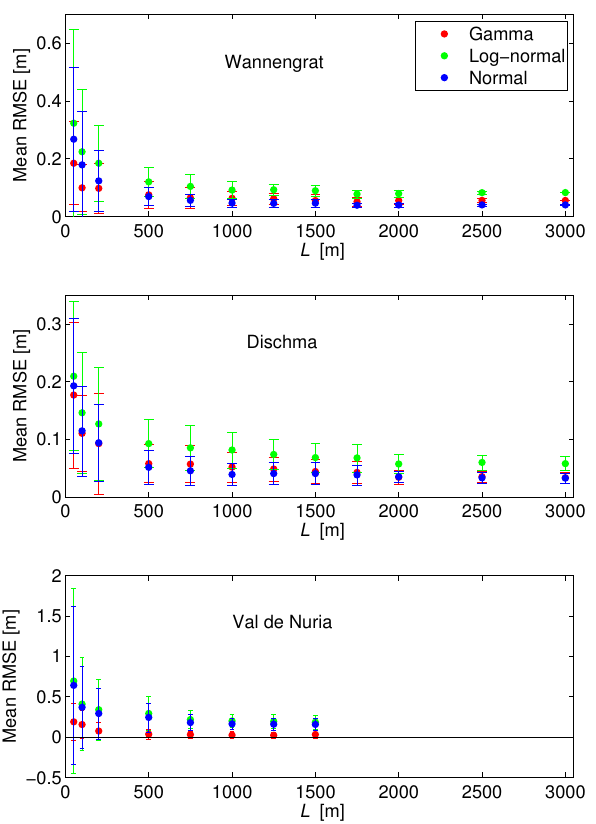
Figure 4. Mean root mean square errors (RMSE) between theoret- ical probability density functions (pdf) and measured pdfs as func- tion of domain size L . Error bars indicate standard deviation of RM- SEs.